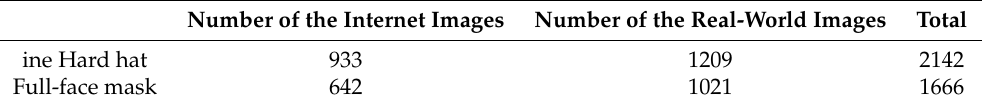
Table 1. Information of collected training